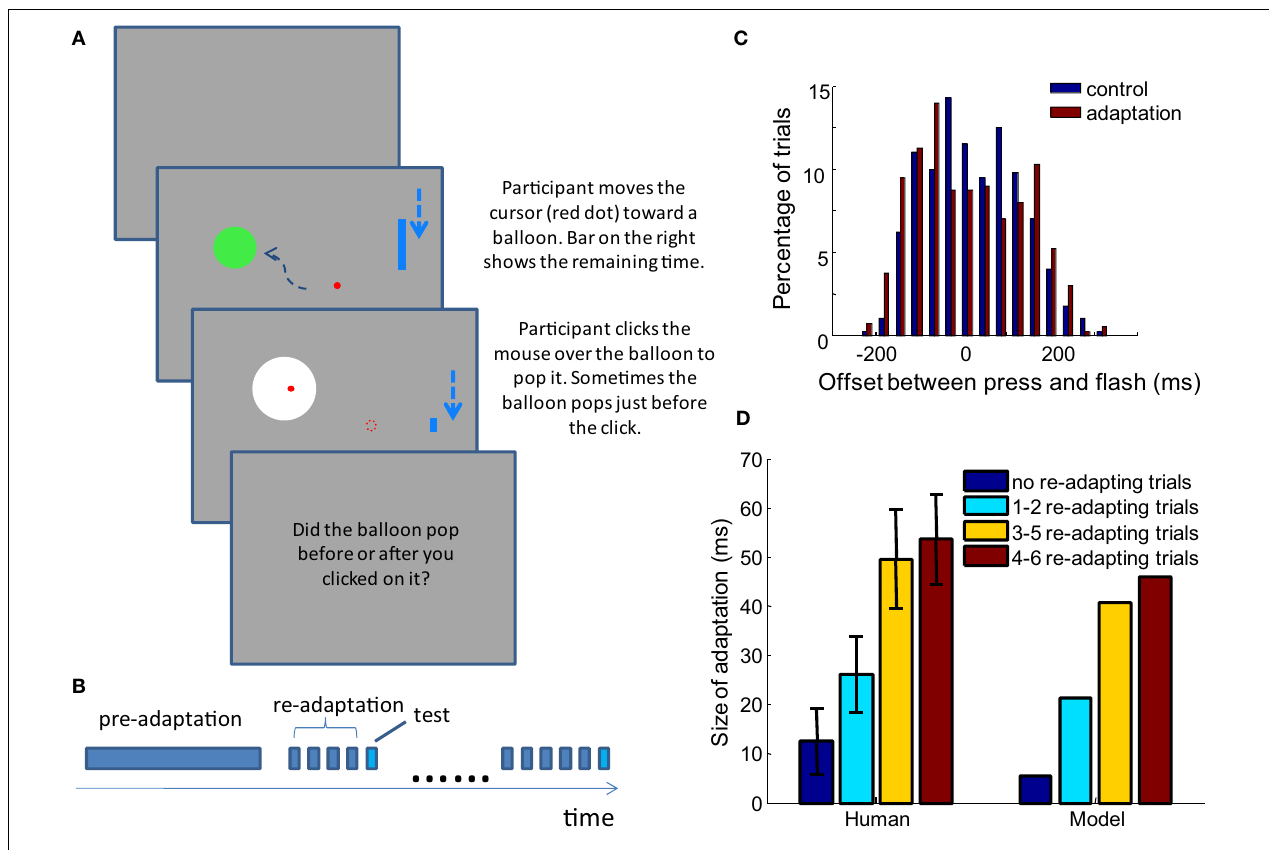
dashed arrows are not seen. (B) Structure of an experiment block: 50 pre-adaptation trials lead to testing phase, in which each test trial is preceded by a random number of re-adapting trials (no such re-adapting trial in 0 re-adapting trial condition). (C) The distribution of the temporal offset for test trials is well balanced in both the control and adaptation blocks.The figure shows the distribution in the 3–5 adapting trial condition across all participants. (D) Using the parameter set obtained in Limited recalibration with increased adapting delays, the model successfully captures the average result of behavioral data. Error bars=SEM. n =31, 16, 18,